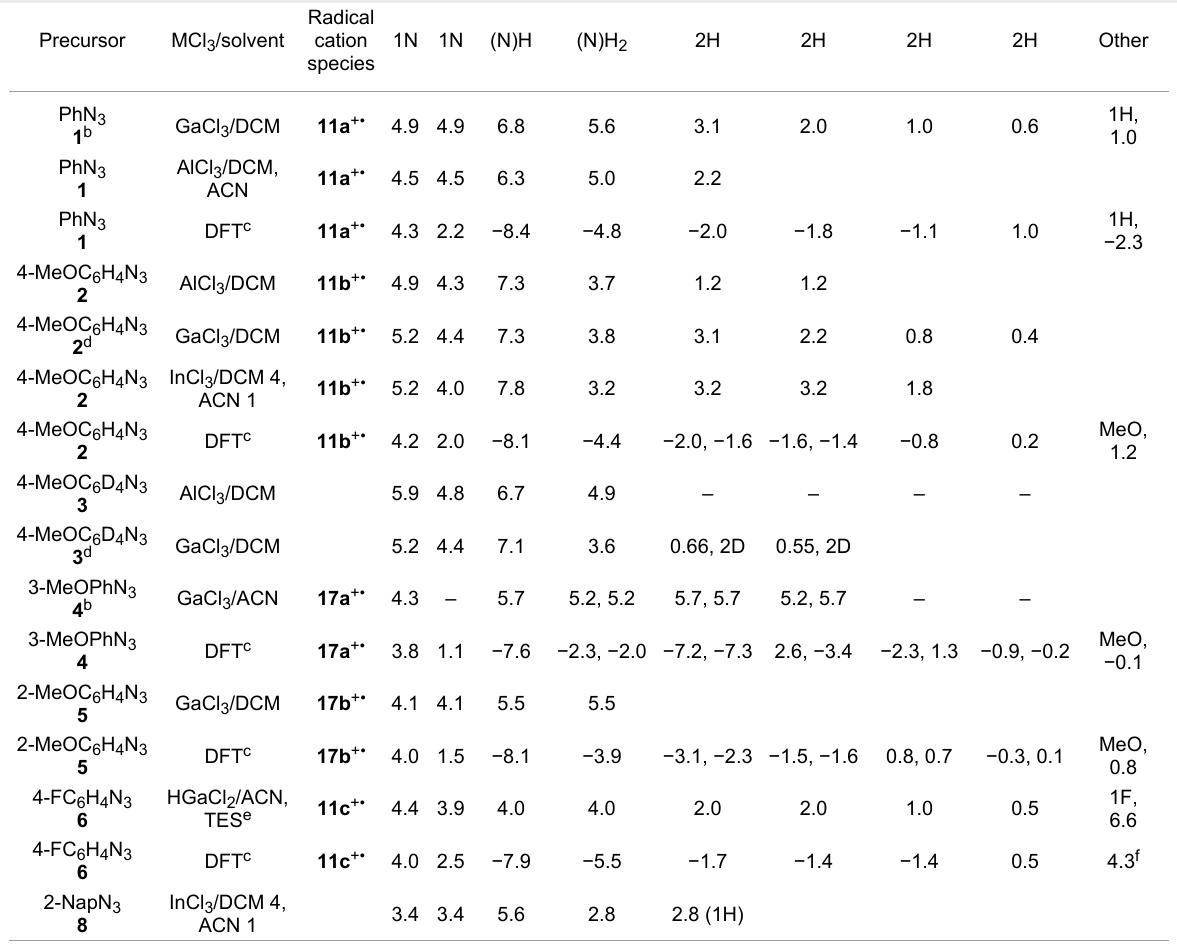
Table 1: EPR parameters of ‘dimers’ [ArNHC 6 H 4 NH 2 ] +• from treatment of aryl azides with group 13 metal chlorides. a